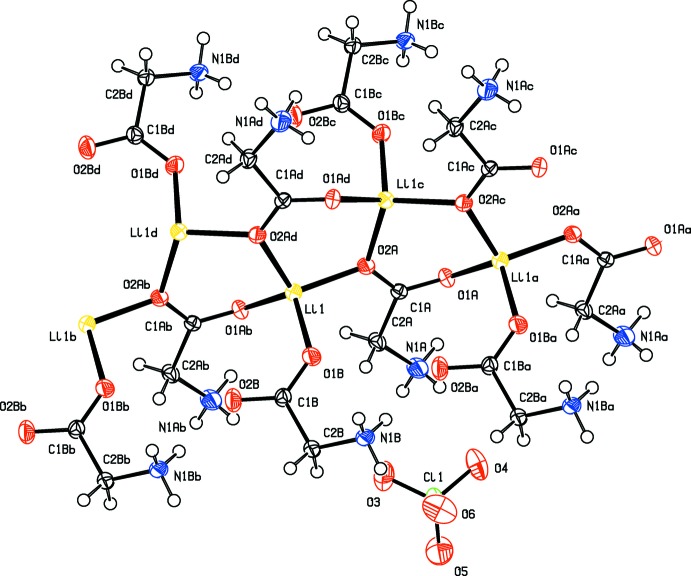
Part of the crystal structure of (I) showing the atomic labelling. Displacement ellipsoids are drawn at the 50% probability level. [Symmetry codes: (a) x, y − 1, z; (b) x, y + 1, z; (c) −x + 1, y − , −z + ; (d) −x + 1, y + , −z + ].